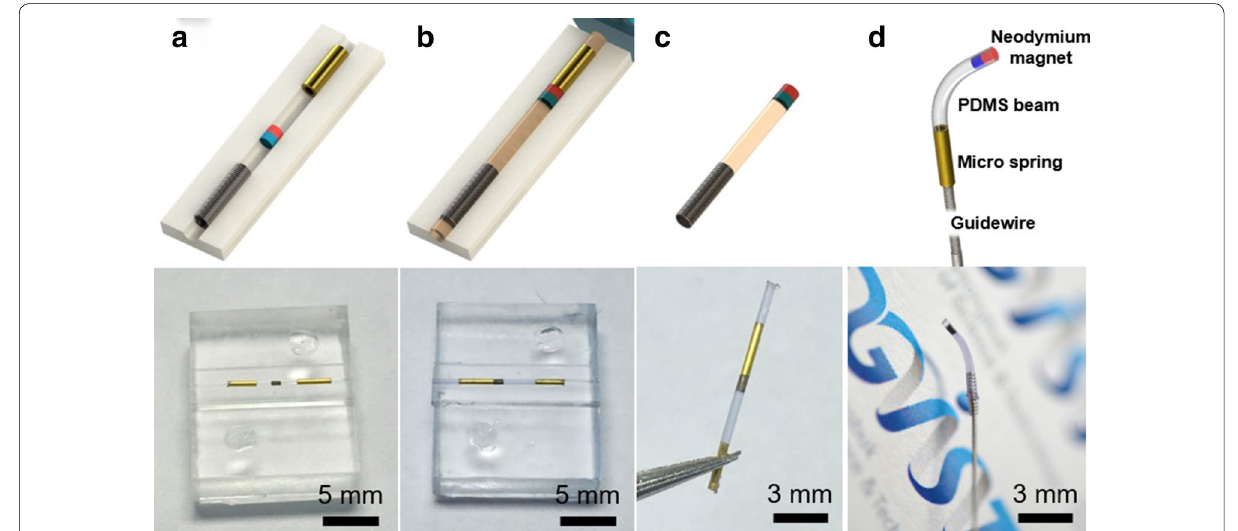
Fig. 4 Fabrication of the guidewire‑based flexible